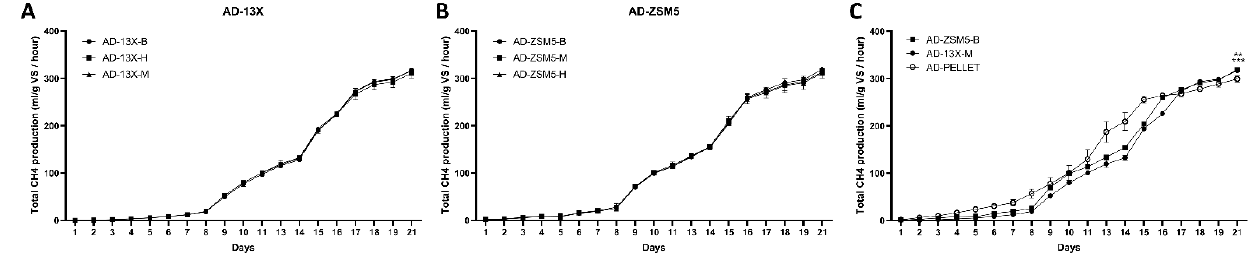
Figure 2. BMP test results of novel 3D-printed zeolite biocarriers: ( A ) 13X zeolite, ( B ) ZSM-5 zeolite, ( C ) mixed plot of AD-13X-M biocarrier, AD-ZSM-5-B biocarrier and AD-PELLET. *** p < 0.001; ** p < 0.01. N = 3.